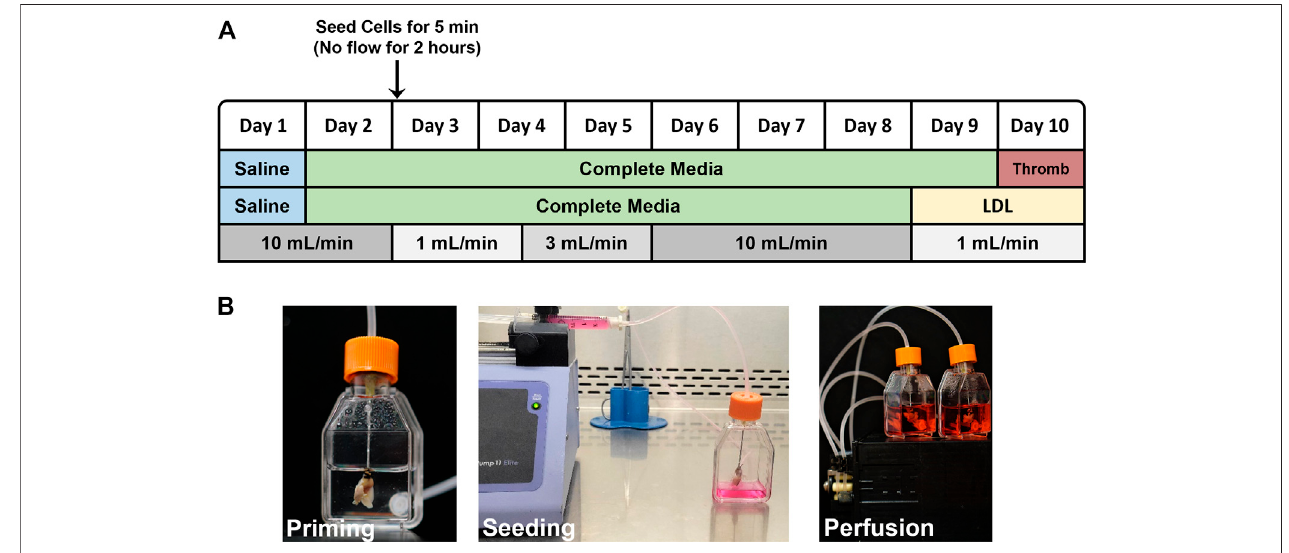
FIGURE 1 | (A) Flow chart outlining the reseeding protocol. LDL-uptake and Thrombogenicity assays were conducted on day 9 and 10, respectively. (B) Photographs showing assembled, modi fi ed tissue culture fl ask bioreactor with attached acellular mouse lung scaffold during priming with saline (left) , injector pump seeding ECs into acellular scaffold via right ventricle (middle) , and reseeded lung scaffolds with 25 ml of media in a closed loop system, attached to pulsatile pump (right)